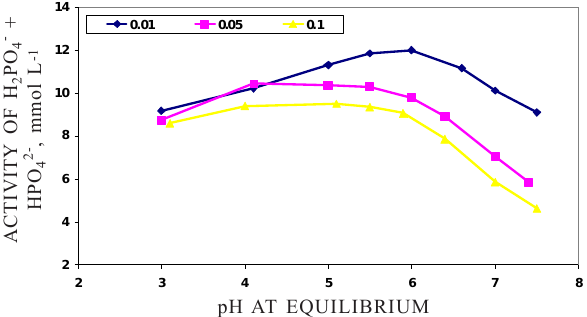
Figure 5. Activity of H PO - + HPO 42- from the 2 hydrolysis reaction of H14-syn as a function of pH at equilibrium of NaCl solutions with concentrations of 0.01, 0.05 and 0.1 mol L -1 .